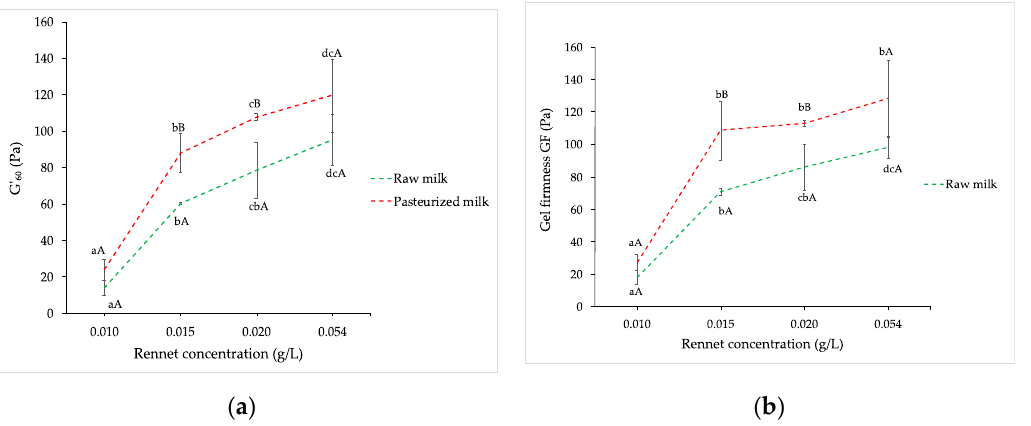
Figure 2. Influence of rennet concentration and heat treatment of milk on: ( a ) gel firmness G’60 (Pa) and ( b ) GF (Pa). Values with different lowercase letters (a, b, c, d) represent differences between levels of rennet concentrations, different uppercase letters (A, B) represent differences between milk heat treatments (raw/pasteurized). Mean comparisons were performed with the Tukey HSD test ( p < 0.05).